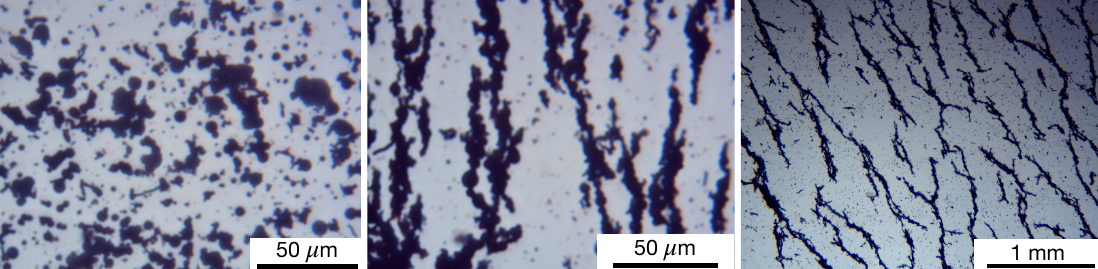
Figure 6. (Color online) Optical microscopy of: ( Left ) CI (black disks) and µ F (black rod-like structures) without an external magnetic field; ( Middle ) CI (black disks) and µ F (black rod-like particles) with an external magnetic field. Magnetic field is in the N-S direction; and, ( Right ) chain-like aggregates of µ F in an external magnetic field. Magnetic field is in the NW-SE direction. The magnetic flux density is about 25